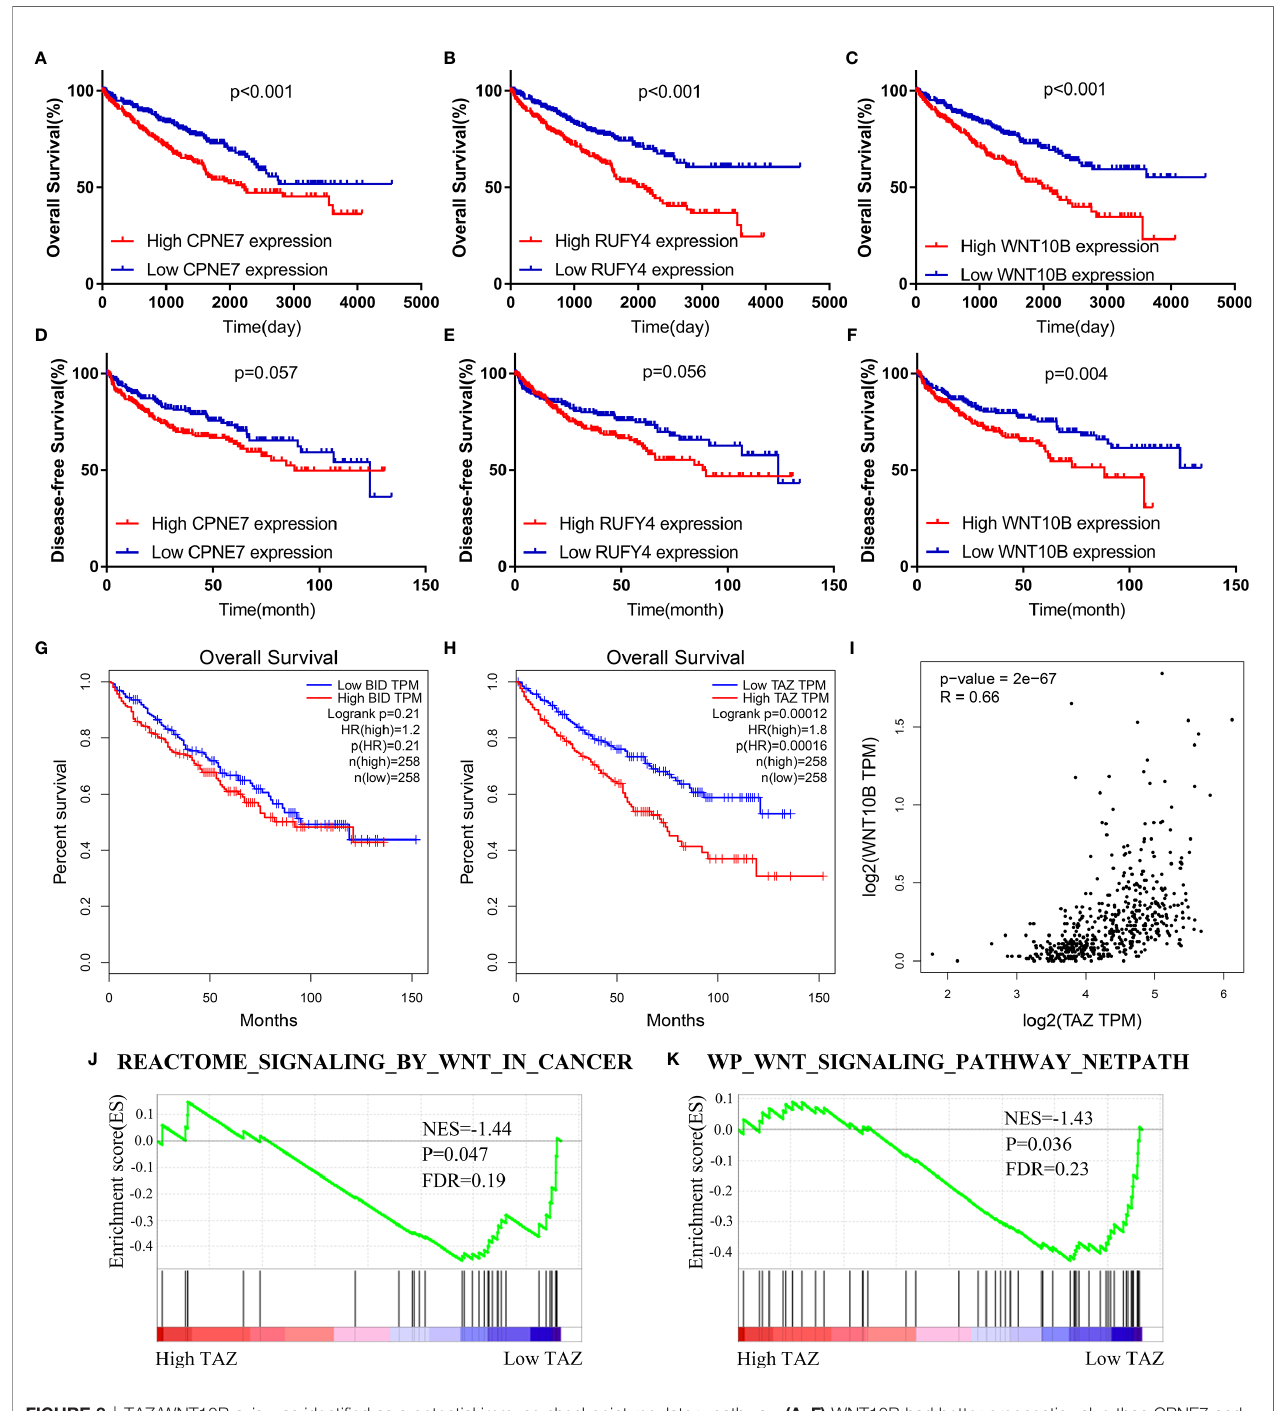
FIGURE 8 | TAZ/WNT10B axis was identi fi ed as a potential immune checkpoint regulatory pathway. (A – F) WNT10B had better prognostic value than CPNE7 and RUFY4 according to survival analysis of OS and DFS. (G, H) Survival analysis revealed that TAZ had better prognostic value than BID. (I) TAZ was closely positively correlated to WNT10B (R = 0.66). (J, K) Low TAZ group was enriched in WNT signaling pathways. OS, overall survival; DFS, disease-free